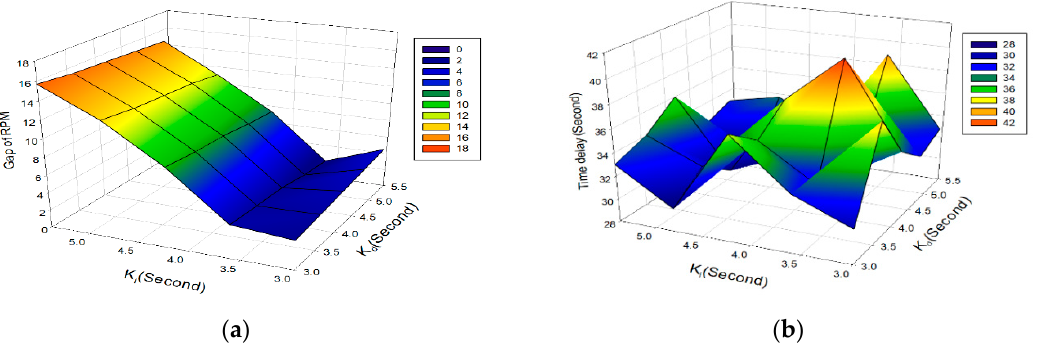
Figure 6. ( a ) RPM accuracy comparison with the integral and differential and ( b ) comparison of reaction rates with changes in the integral and differential.